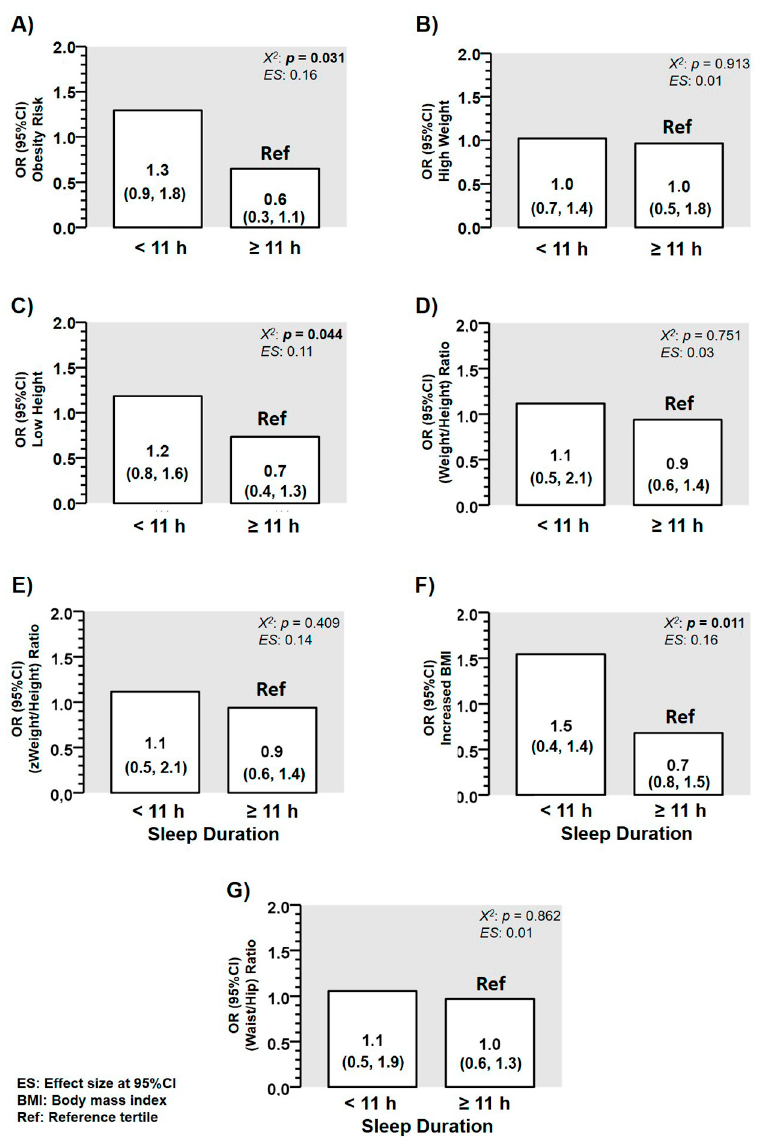
Figure 4. Characteristics of different anthropometric outcomes in a sample of Chilean preschoolers ( n = 99) according with their odds ratio (OR) for suffering or not the following conditions by panels; ( A ) OR for suffering from higher “overweight/obesity” prevalence, ( B ) OR for suffering from “excess from weight”, ( C ) OR for suffering from “low height”, ( D ) OR for suffering from “elevated weight/height ratio”, ( E ) OR for suffering from “elevated z score weight/height ratio”, ( F ) OR for suffering from “elevated waits-to-hip ratio”, and ( G ) OR for suffering from “elevated waist/hip ratio. (ES) Denotes Cohen d effect size.